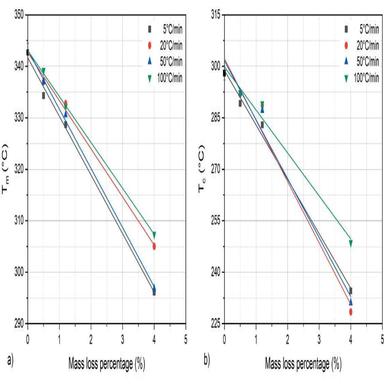
a) Tm and b) Tc of PEEK as degradation progresses for the heating rates of 5, 20, 50 and 100 ◦C/min.